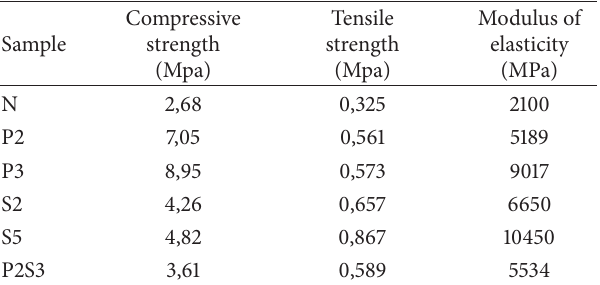
Table 1: The mechanical properties of the plaster material.